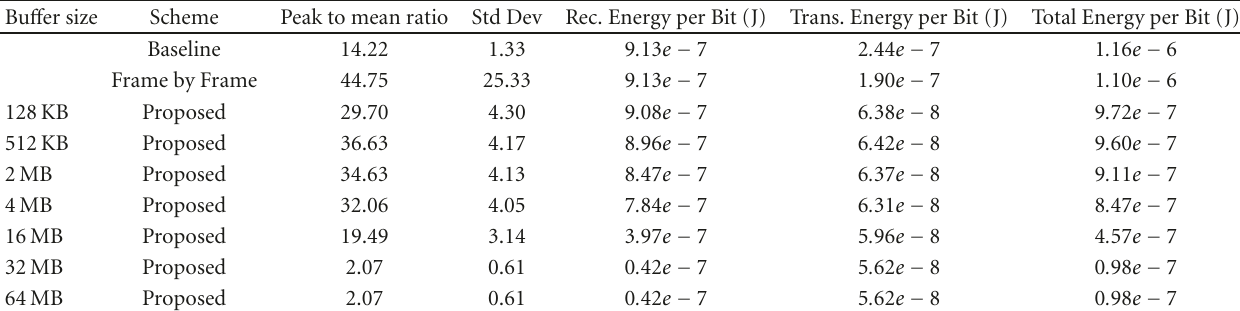
Table 5: Performance comparison for di ff erent bu ff er sizes for Stream 2 ( d = 15 m). Bu ff er